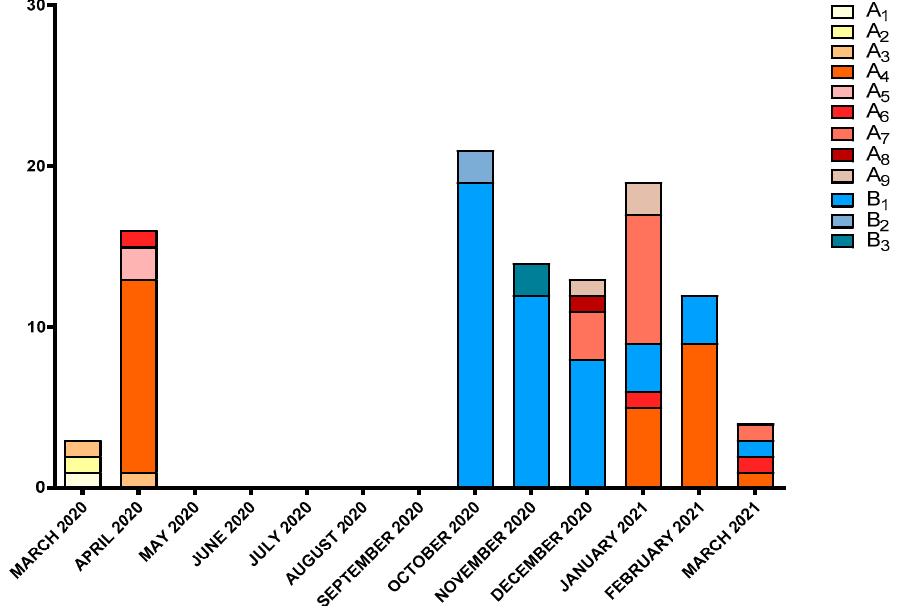
Figure 2. Temporal distribution and frequency of the PFGE patterns of A. baumannii strains isolated from SARS ‑ CoV ‑ 2 patients admitted to the intensive care unit of Umberto I teaching hospital between 1 March 2020 and 28 February 2021 (follow ‑ up extended until 30 March 2021). Around 40% of the genotyped isolates were responsible for HAIs: the majority were VAP for both genotypes patterns (pattern A: n = 18 and pattern B: n = 10), followed by CAUTIs (pattern A: n = 2 and pattern B: n = 4) (Table 1). The remaining genotyped strains were colonizations, in which the bacterium was isolated mainly from rectal swab (38.5% of pattern A and 36.0% of pattern B), followed by bronchial aspirate (15.4% of pattern A and 2.0% of pattern B), central venous catheter and urine (4.0% each in pattern B only), and abdominal drainage (2.0% of pattern A). As for the room of detection, the vast majority of isolates belonging to pattern A were found in the large seven ‑ bed room (63.5%), whereas the distribution of pattern B strains was more balanced between the large room (26.0%), room 4 (22.0%), and room 5 (20.0%). Table 1. Characteristics of the genotyped A. baumannii strains isolated by major pulsed ‑ field gel electrophoresis (PFGE) pattern from SARS ‑ CoV ‑ 2 patients admitted to the intensive care unit of the Umberto I teaching hospital of Rome between 1 March 2020 and 28 February 2021. Results are expressed as number and percentage. PFGE Pattern A PFGE Pattern B n (%) n (%) Isolate type Healthcare ‑ associated infection VAP